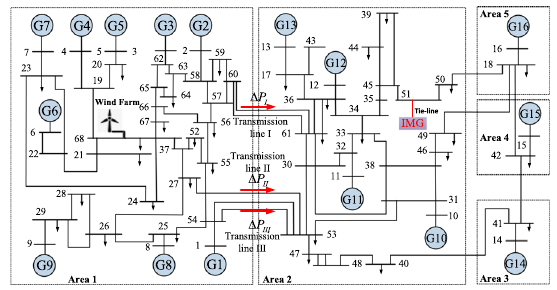
Fig. 12 IEEE 68-bus power system connected with the